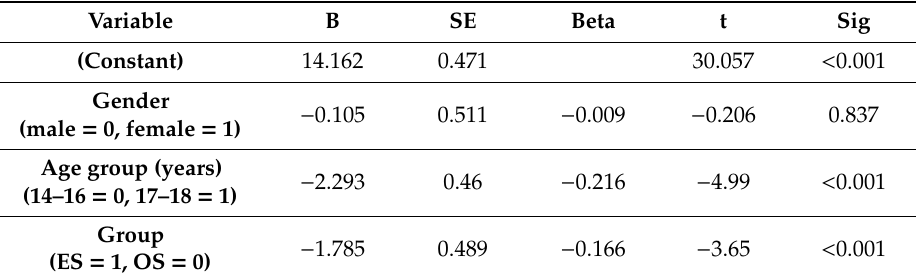
Table 4. Results of the multiple linear regression model.